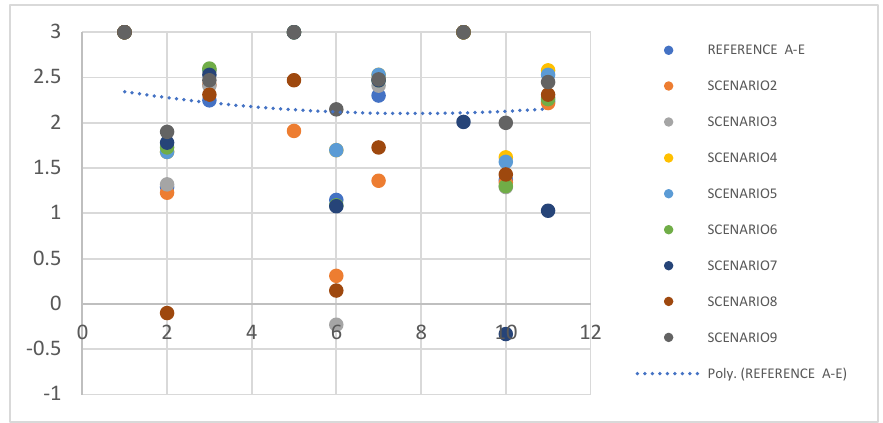
Figure 7. Comparison between the PMV values in the base case and mitigation scenarios.